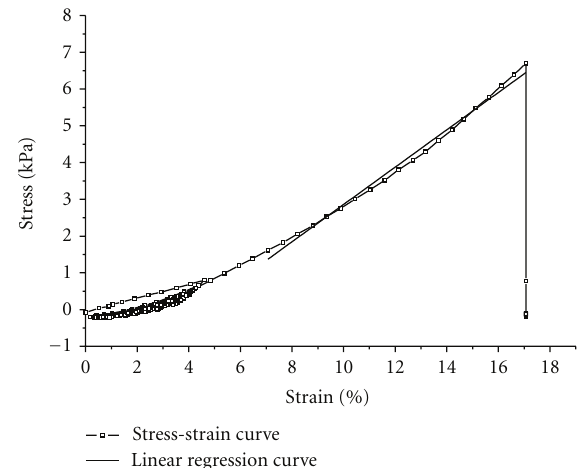
Figure 2: Example of a stress-strain curve obtained from a tensile test on a preconditioned collagen gel (10 cycles of loading and unloading) in air at 23 ◦ C. Linear modulus was calculated from the slope of the linear regression. The linear regression was determined by successively adding points in data in the left direction (starting from the point at rupture) as long as the squared R was > 0.990.